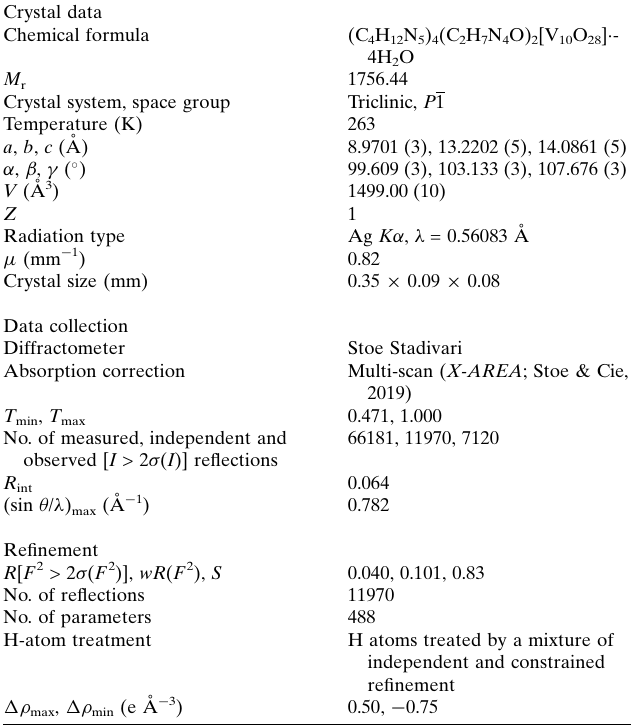
Crystal data Chemical formula